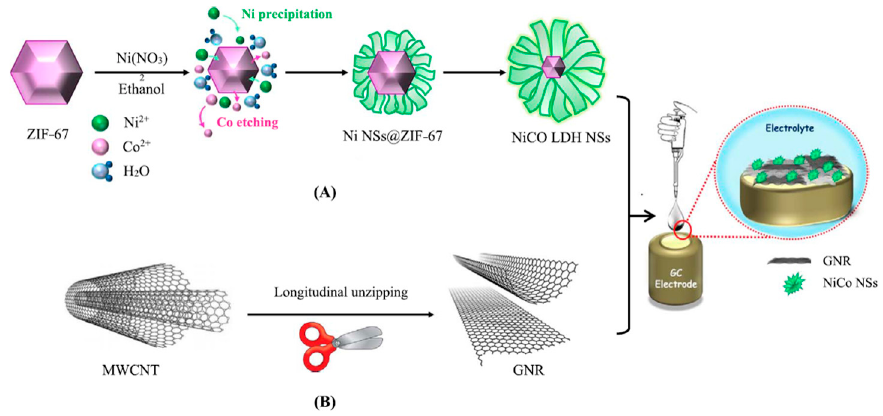
Figure 12. Scheme of the GC electrode modi fi cation procedure: ( A ) the synthesis of NiCo LDH NSs and ( B ) the preparation of narrow graphene nanoribbons [103]. Copyright: Elsevier B.V.